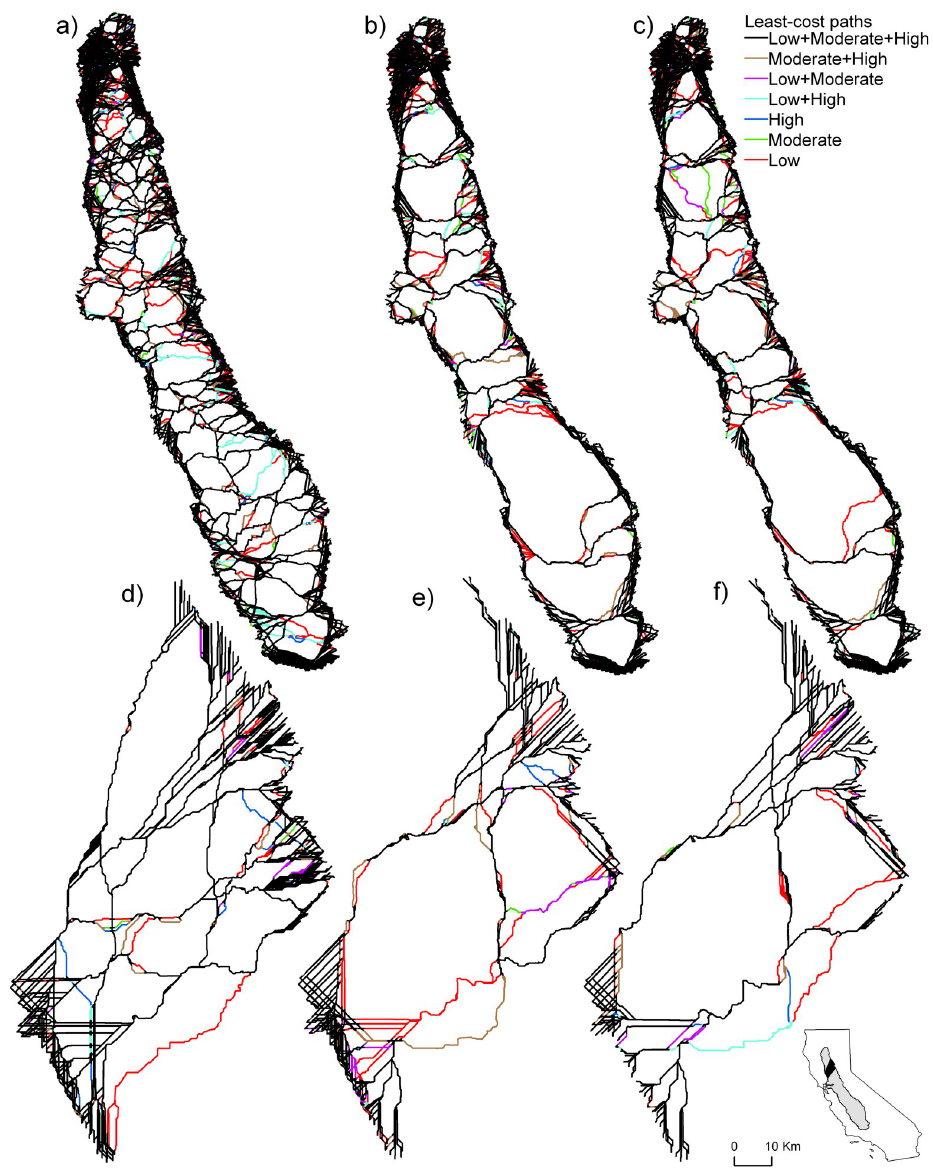
Fig 3. Resistance to movement maps used to parameterize the Central Valley pollinator connectivity models. Maps depict the resistance surfaces used for the a) restored margins scenario, b) current margins scenario, and c) no margins scenario. Colors range from low resistance (blue) to high resistance (red). A resistance value of 1 is equivalent to isolation-by-distance, while a value of 100 indicates that a grid cell is 100 times more difficult to traverse than the lowest-resistance